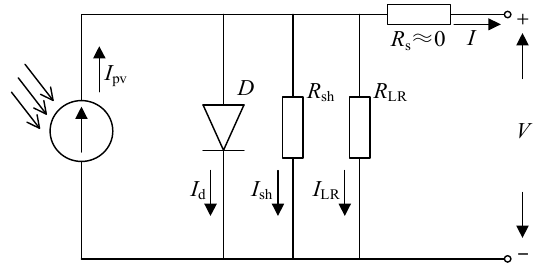
Figure 1. Simplified model of unshaded hot-spot unit.